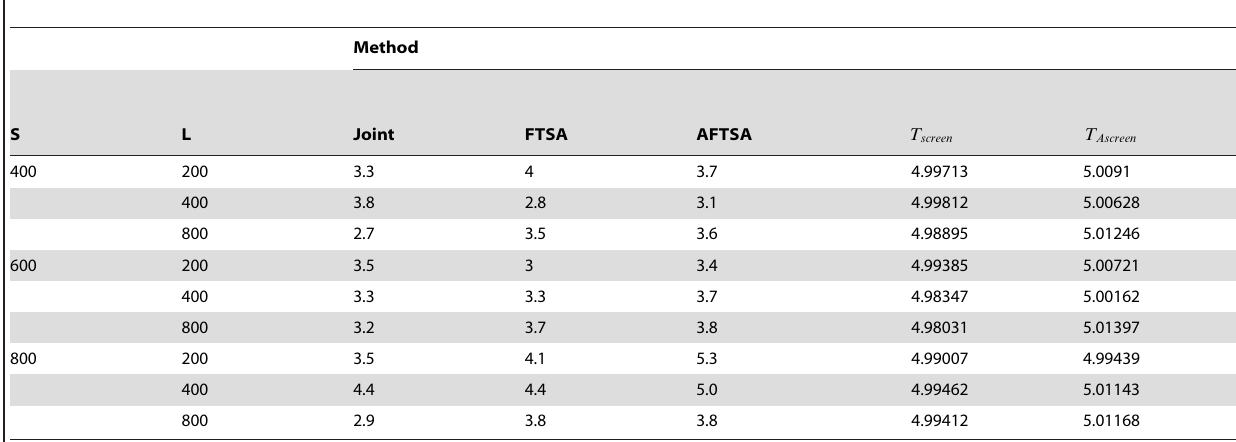
Table 1. Type I error rates (in percentage) of the five tests based on simulation set 1.